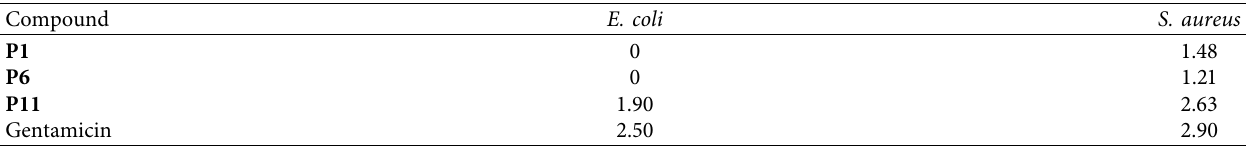
Table 1: Zone of inhibition of synthesized compounds (250 µ g/mL) and standard drug gentamicin (250 µ g/mL) against Gram-positive and Gram-negative bacteria after